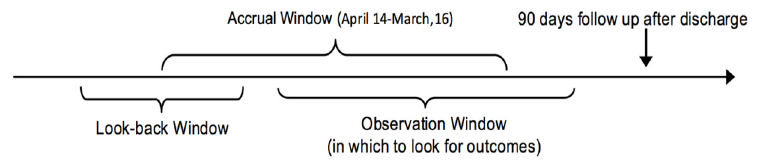
Figure 2. Provides an overview of data creation plan and how we prepared the final